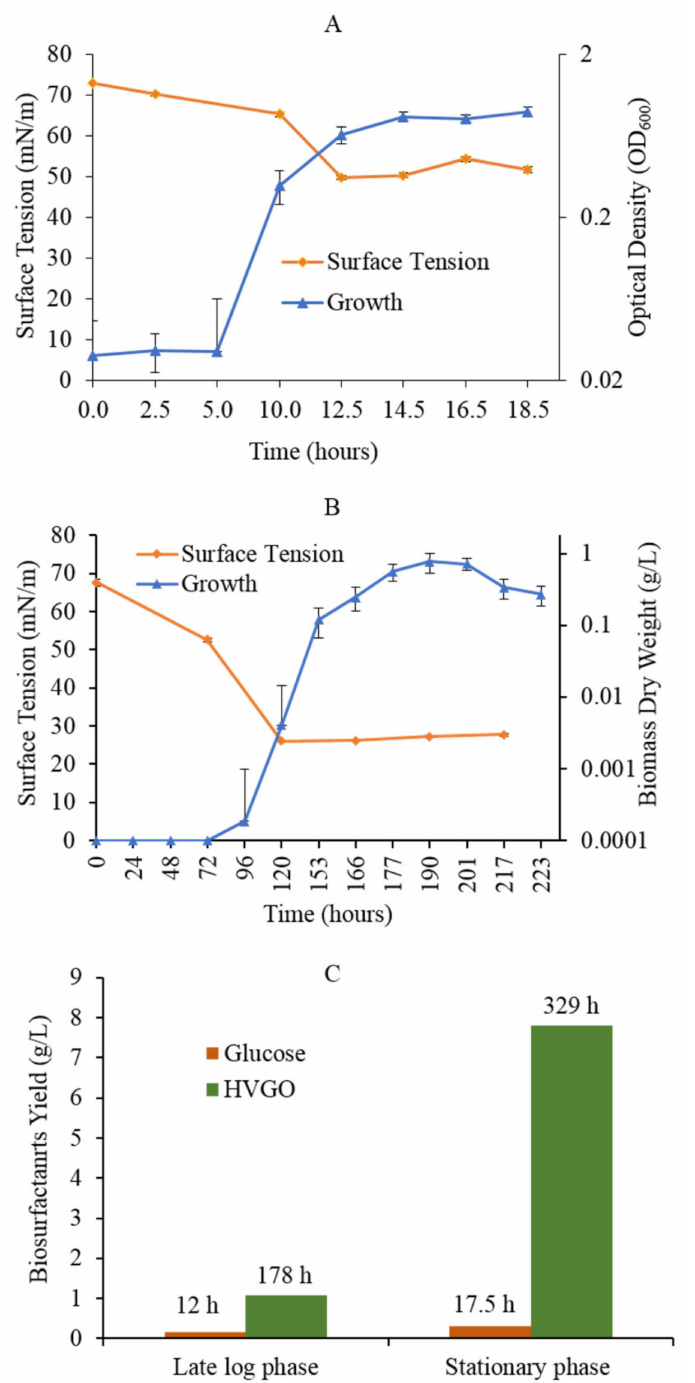
Figure 2. Growth profile and biosurfactants production kinetics of the glucose ( A ) and HVGO ( B ) cultures of the AK6U strain, and biosurfactants yield ( C ). Growth is plotted on a logarithmic scale. Time points at which biosurfactants were extracted from the cultures are indicated above the columns in panel C. Error bars represent standard error (number of biological replicates =